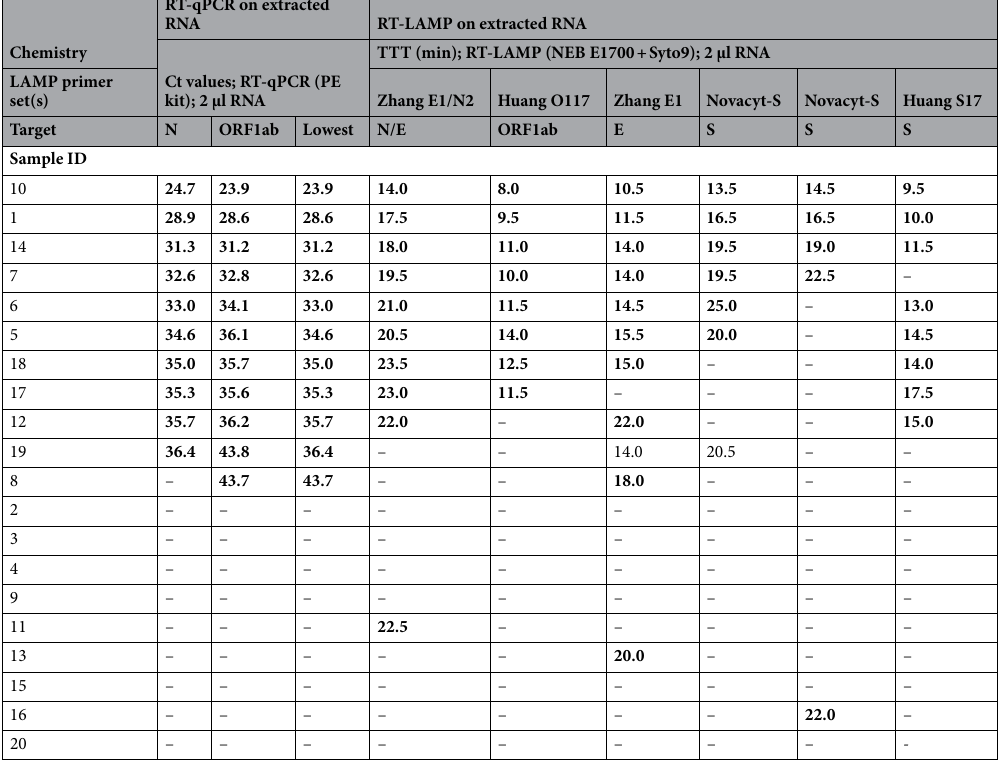
Table 1. Comparison of RT-LAMP and RT-PCR results from extracted RNA from clinical saliva samples. 2 μl of purified RNA from 20 clinical saliva samples were used for each assay type to provide a fair comparison. RT-LAMP primer sets are ordered (left-to-right) from highest to lowest performer. Performance was measured by the highest Ct below which 100% sensitivity was achieved. Samples are ordered (top-to-bottom) by viral load, from lowest Ct to highest Ct. PE kit: PerkinElmer New Coronavirus Nucleic Acid Detection Kit. TTT: time to threshold, where threshold is defined as 1.5 × baseline. Dash (–) denotes either no detection of target by 45 cycles of RT-PCR or fluorescence signal did not reach threshold by 30 min in